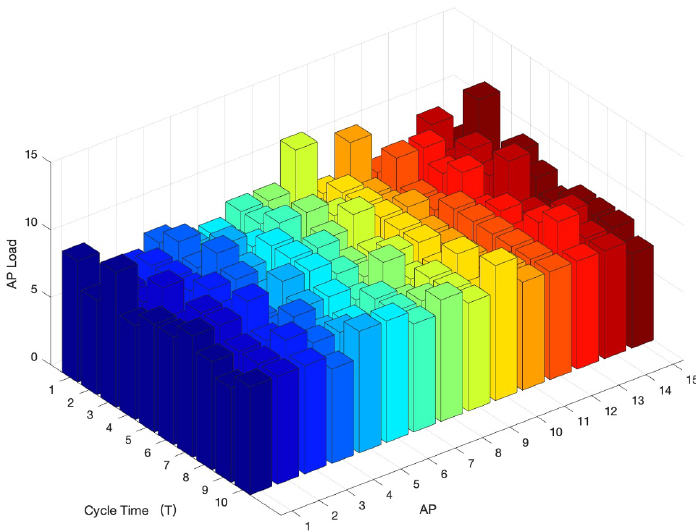
Figure 11. HWCA algorithm for load